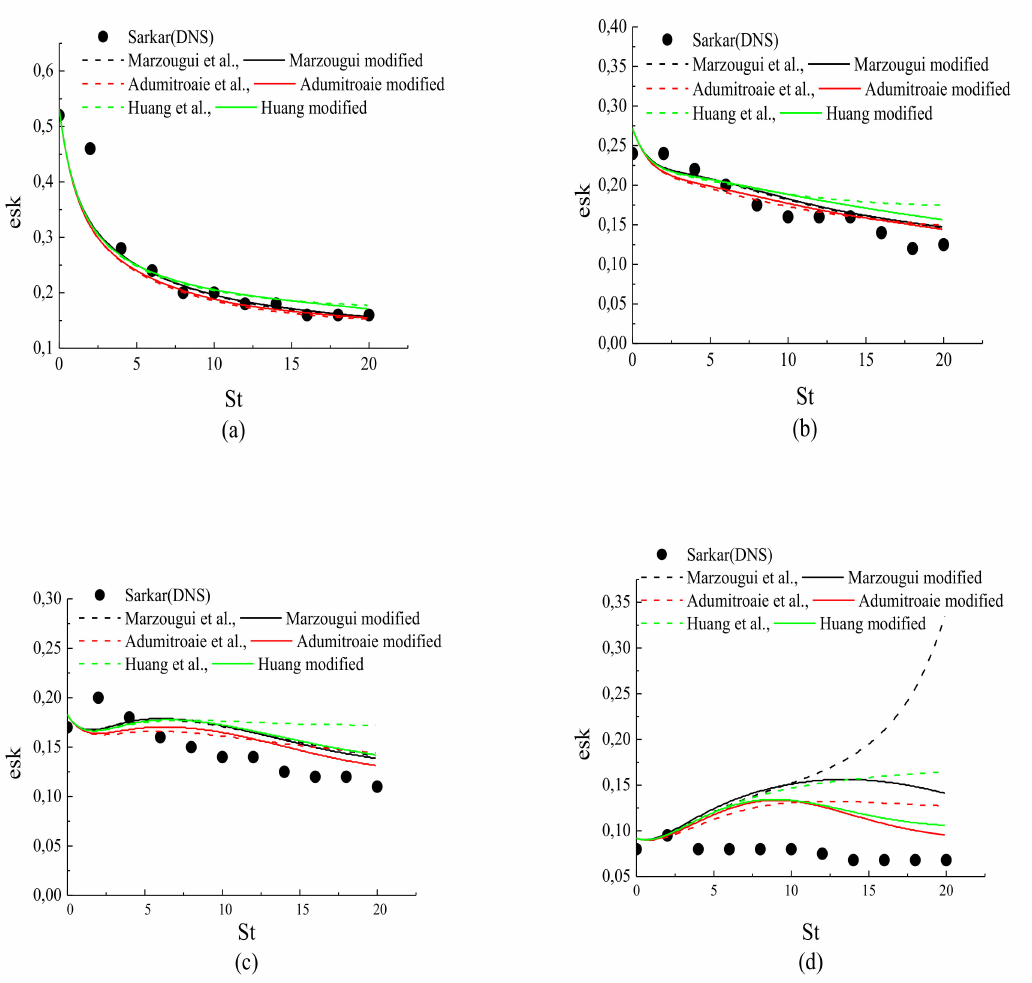
Figure 1. Time evolution of the normalized dissipation, (esk = ε s / SK in the following cases: ( a ) A1; ( b ) A2; ( c ) A3; ( d )